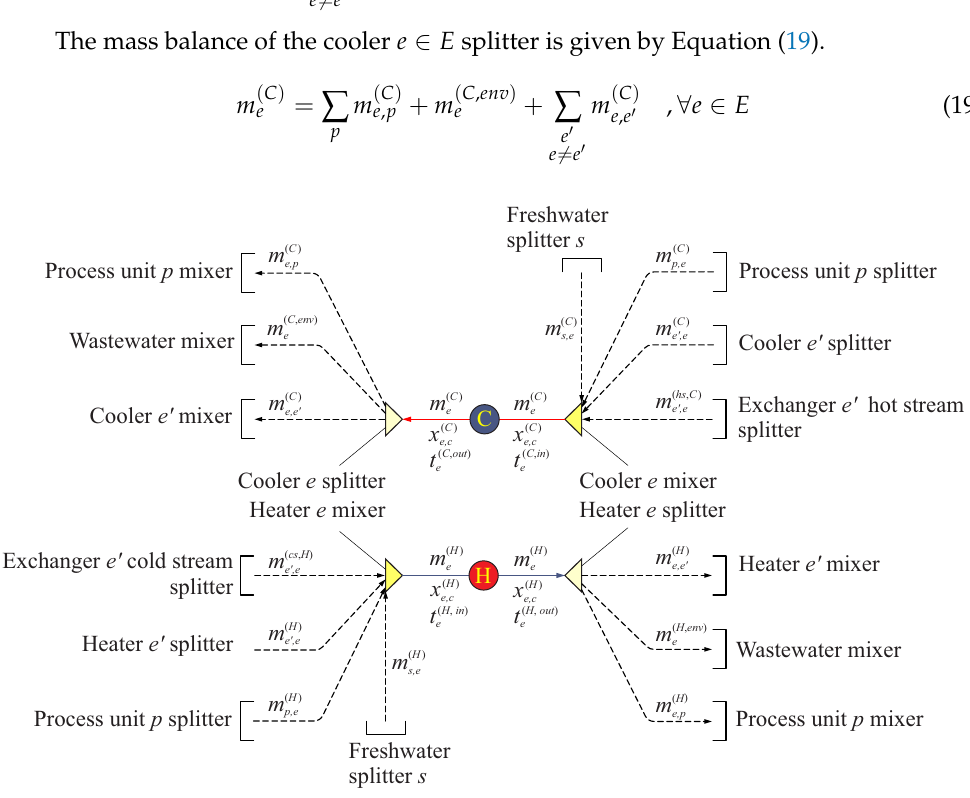
Figure 8. Cooler and heater with corresponding